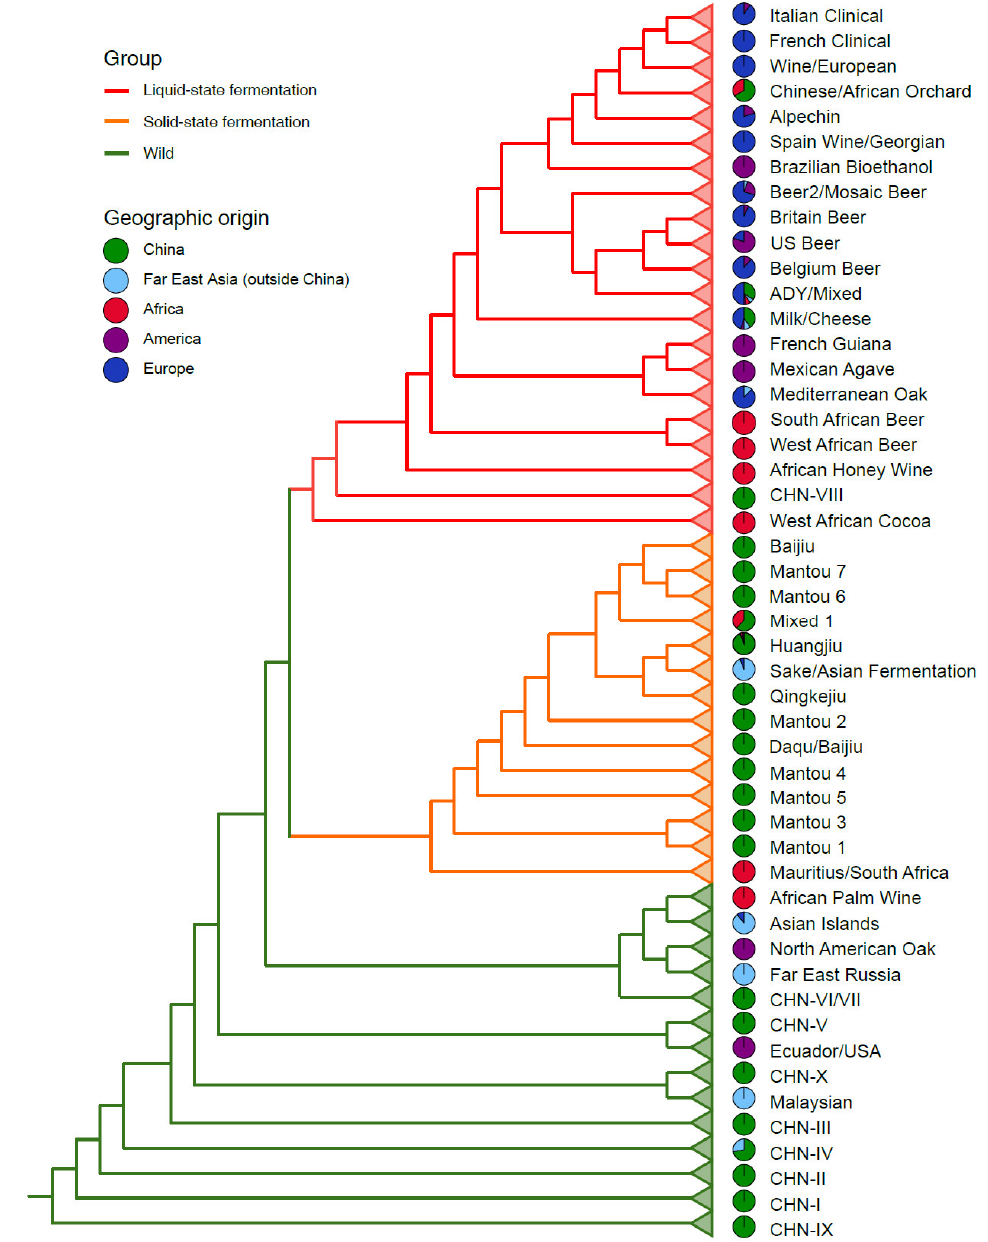
Figure 4. A schematic diagram showing the phylogenetic relationships of the recognized lineages of S. cerevisiae . The dendrogram is drawn according to the phylogenomic analysis performed by Han et al. [22] based on genome-wide SNPs from a set of S. cerevisiae strains representing the maximum global genetic diversity and almost all recognized lineages of S. cerevisiae , however, branch lengths do not exactly correspond to genetic distances between different lineages. The mosaic strains are not included. The wild and domesticated (liquid- and solid-state fermentation) groups are distinguished using branch lines with different colors. The pie charts represent the geographic origins of the strains in each lineage.